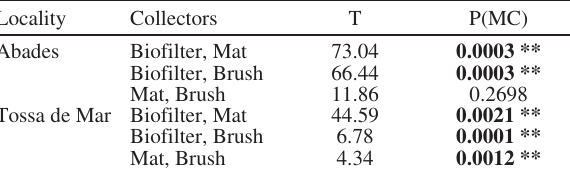
Table 2. – Pairwise comparisons for the significant interaction of factors ‘Collector × Locality’ obtained in the permutational analysis of variance (PERMANOVA) assessing differences in number of P. lividus settlers. Differences in settler abundances at Abades (in February 2012) and at Tossa de Mar (in June 2012) among the three types of artificial collectors tested are given. Significant results are shown in bold (** p<0.01).